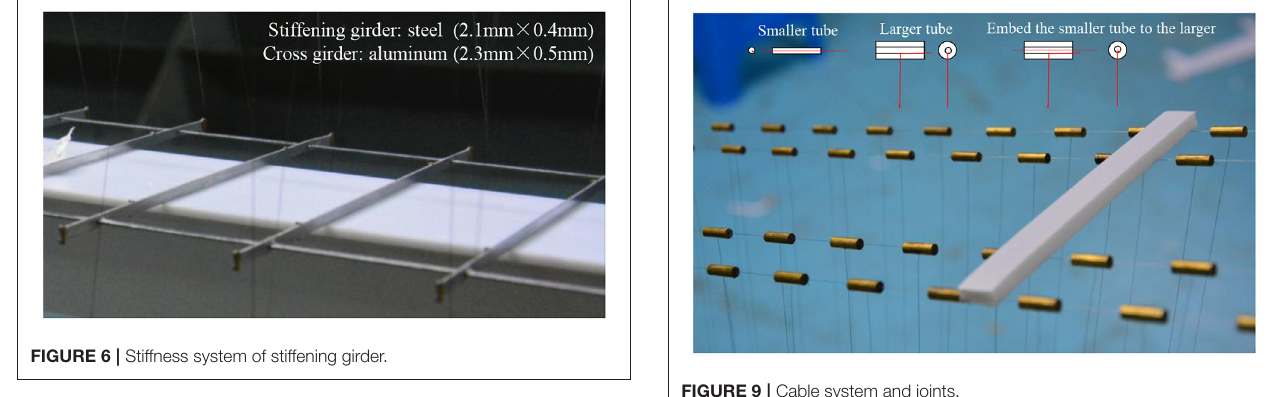
FIGURE 9 | Cable system and joints.